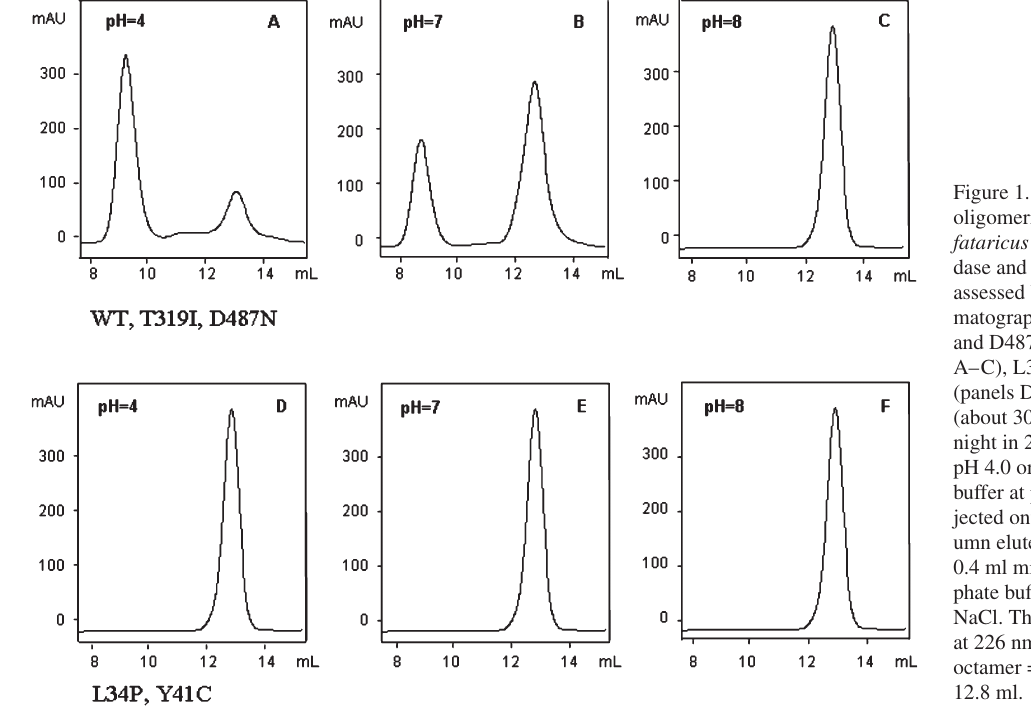
Figure 1. Effect of pH on the oligomeric state of Sulfolobus sol- fataricus recombinant WT ami- dase and site-specific mutants assessed by gel permeation chro- matography. WT protein, T319I and D487N mutants (panels A–C), L34P and Y41C mutants (panels D–F). Each protein (about 30 µg) was incubated over- night in 20 mM citrate buffer